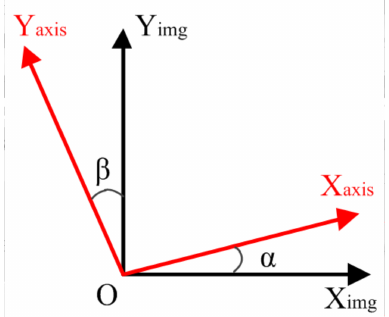
Figure 10. The relationship between the manipulator’s motion axis and the SEM imaging axis.